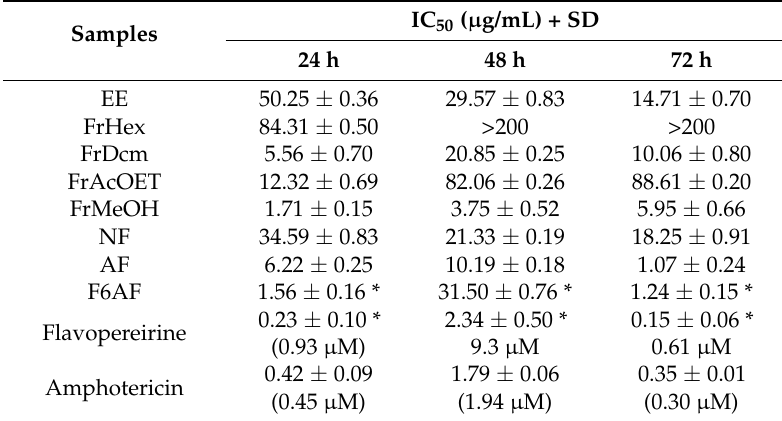
Table 2. The anti-promastigote activity of G. Vellosii.